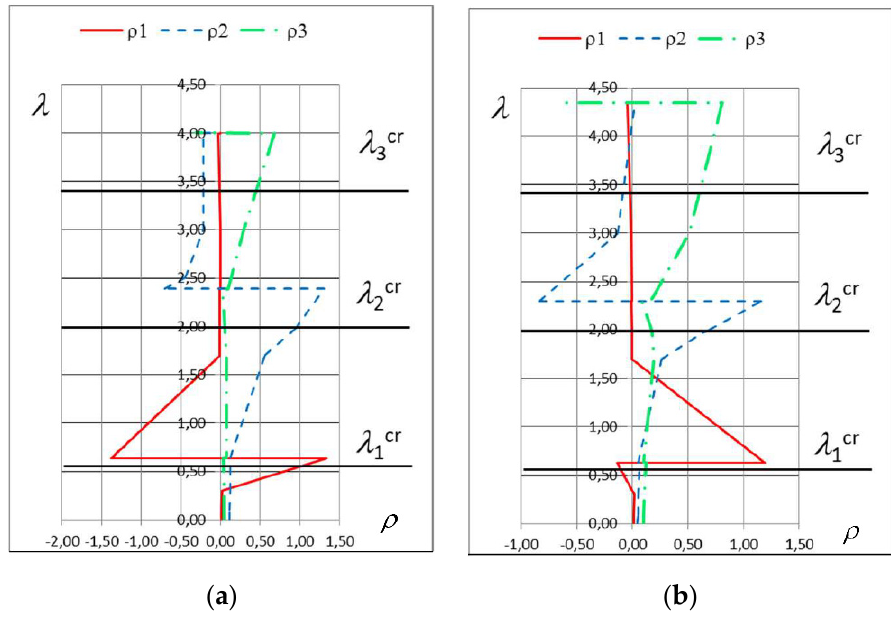
Figure 23. Coefficient ρ for geometrical imperfections: ( a ) m 1 d 2 s 3, ( b ) m 1 s 2 d 3.